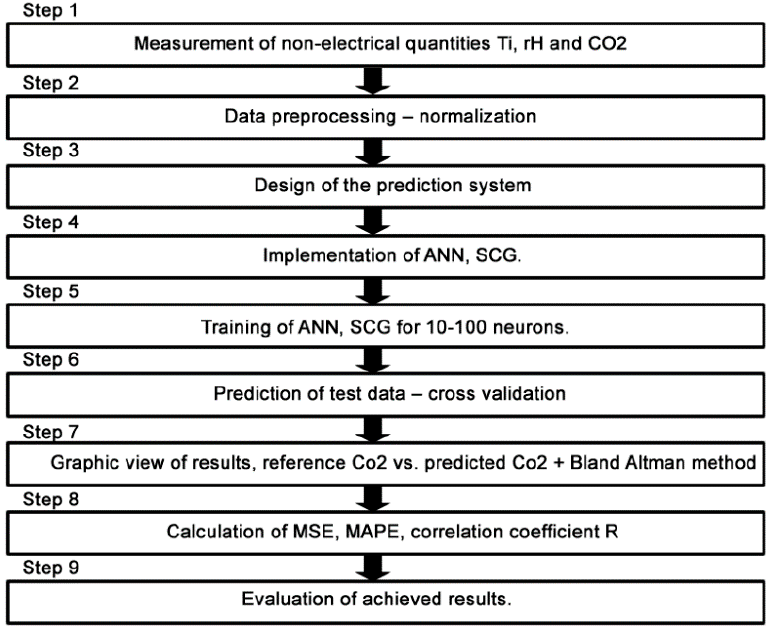
Figure 16. Waveforms of the CO 2 concentration values measured in SH room R204 (BT